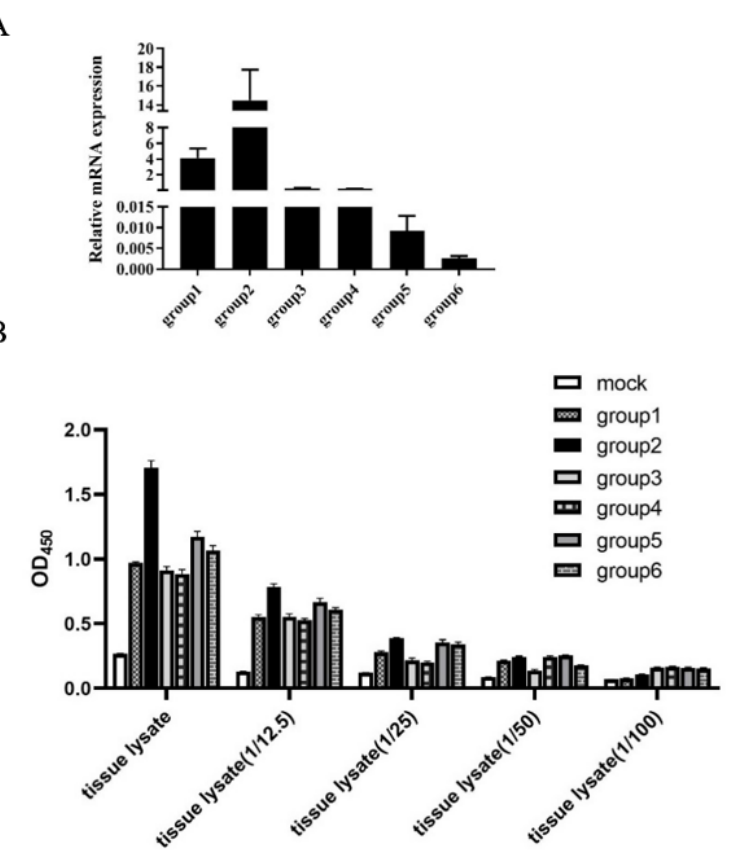
Figure 6. Detection of LMBV in fish samples by sandwich ELASA: ( A ) The results of qRT-PCR for LMBV infection in fish samples. The mean values and SD of three independent experiments were used for analysis. ( B ) The sandwich ELASA detect LMBV infection in samples of spleen lysates even diluted 1/25.